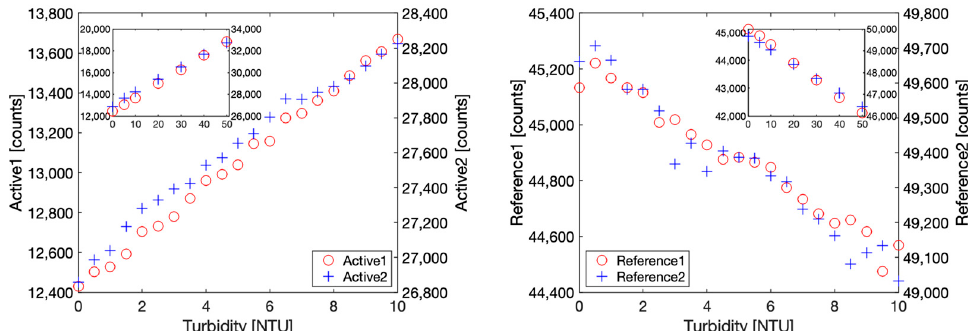
Figure 8. Calibration experiment with Formazin solutions showing ADC output expressed in counts. Main graphs represent data from 0 to 10 NTU with 0.5 NTU increments, while inset shows the 0 to 50 NTU range. Left : 90° nephelometric configuration ADC counts for Active1 and Active2 signals. Right : 180°attenuation configuration ADC counts for Reference1 and Reference2 signals.